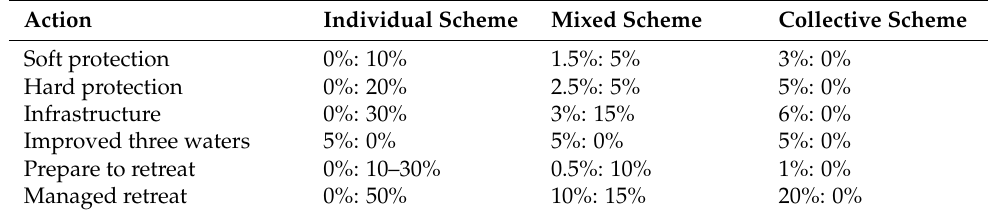
Table A1. Implementation cost of each pathway under each of the three cost apportionment schemes. Costs are shown as A%: B%, with A being the percentage of net worth reduction for all agents, and B% the percentage of net worth reduction for individually impacted agents for each